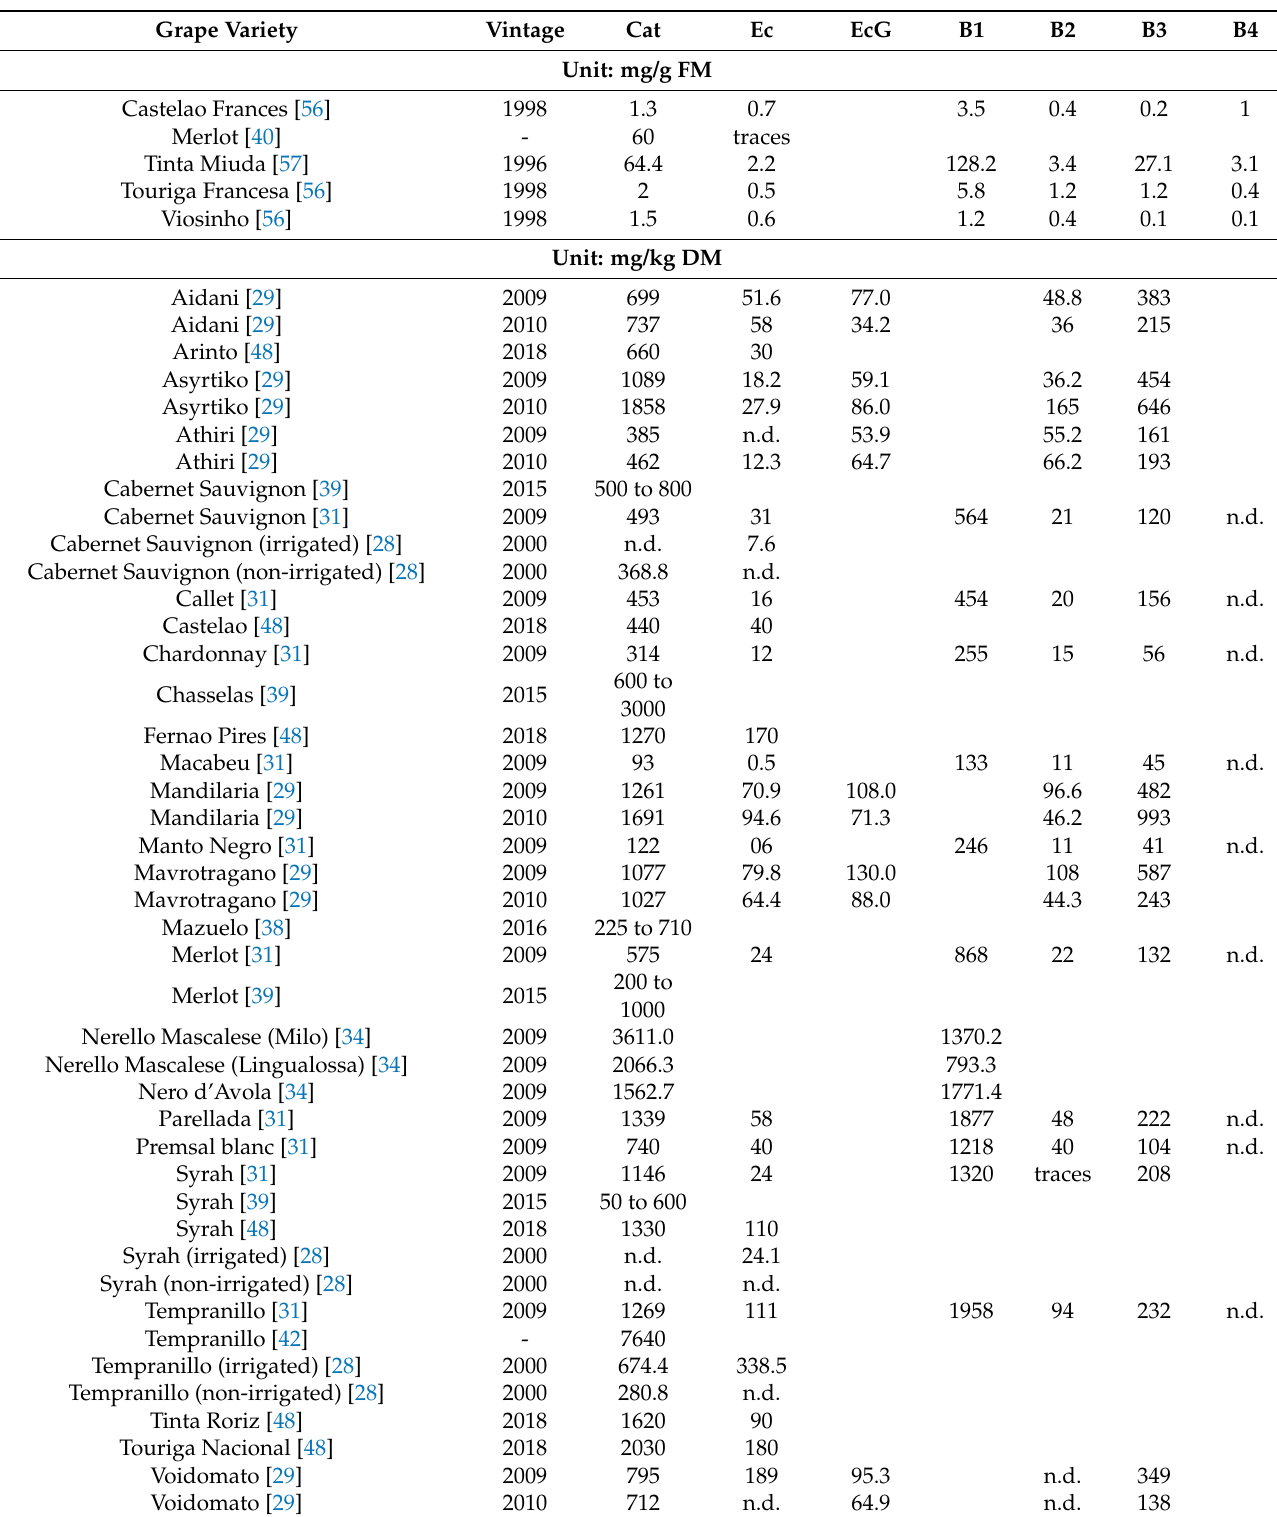
Table 7. Quantification of different flavan-3-ols and proanthocyanidins in grape stem extracts. Grape